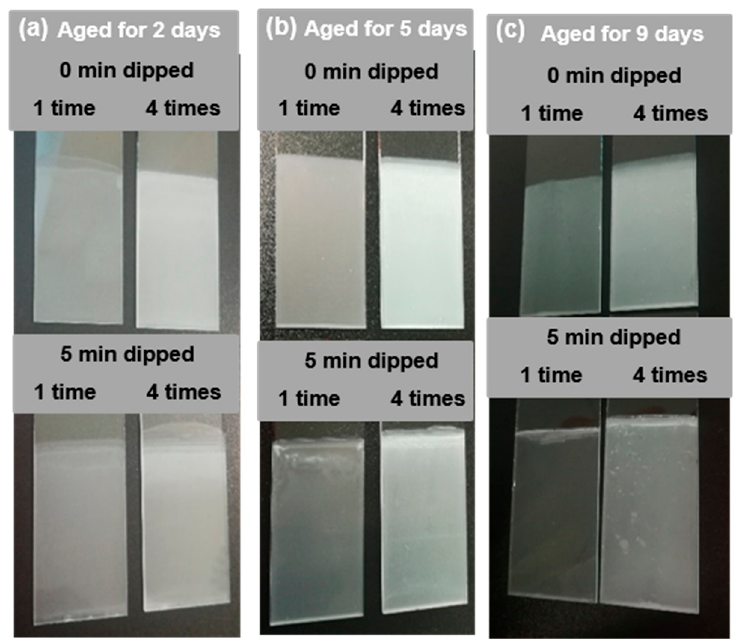
Figure 3. Representative images of the coatings aged for ( a ) 2, ( b ) 5 and ( c ) 9 days.